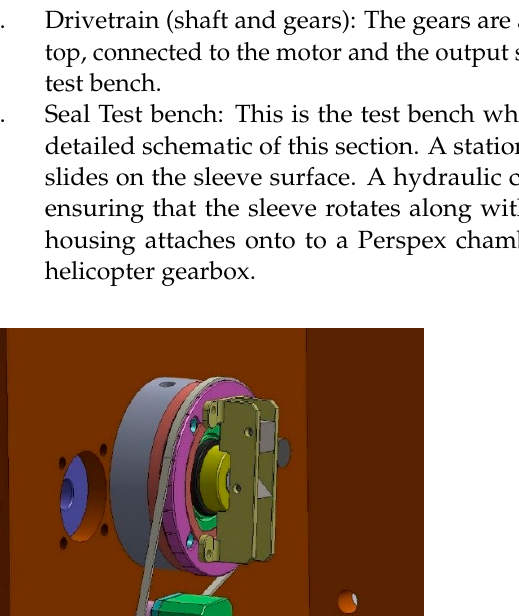
Figure 5. Detailed angled view of seal test bench section of the test rig.